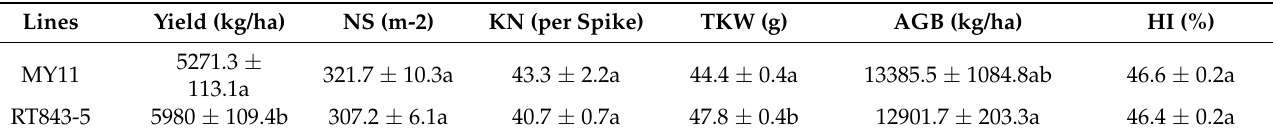
Table 3. Analysis of agronomic traits of